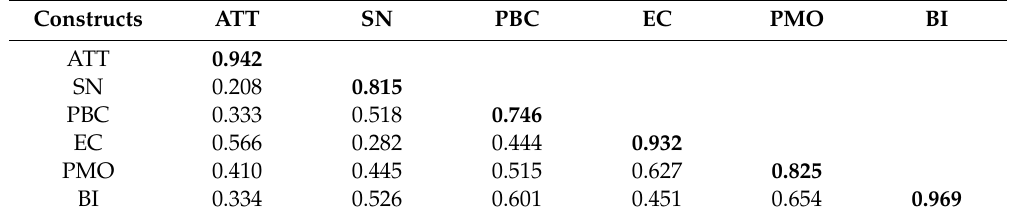
Table 4. Correlation coe ffi cient matrix and square roots of